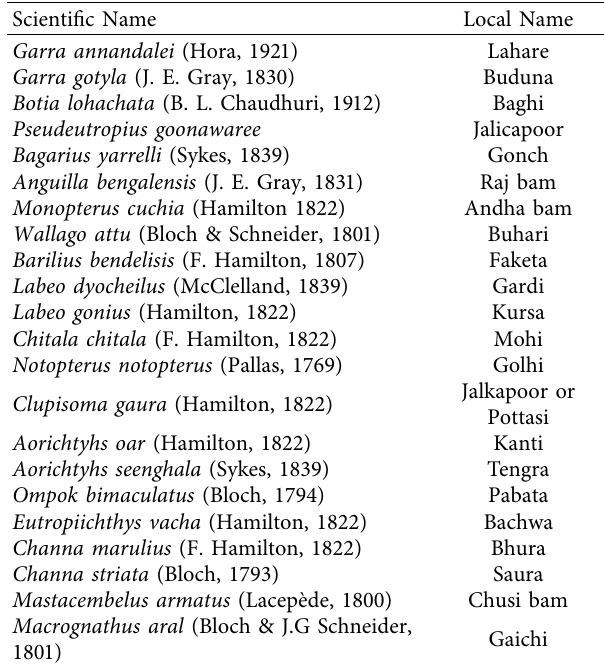
Table 6: List of ornamental finfishes in Nepal. Table 7: Suitable local fish species that can be domesticated in the coming days in Nepal.